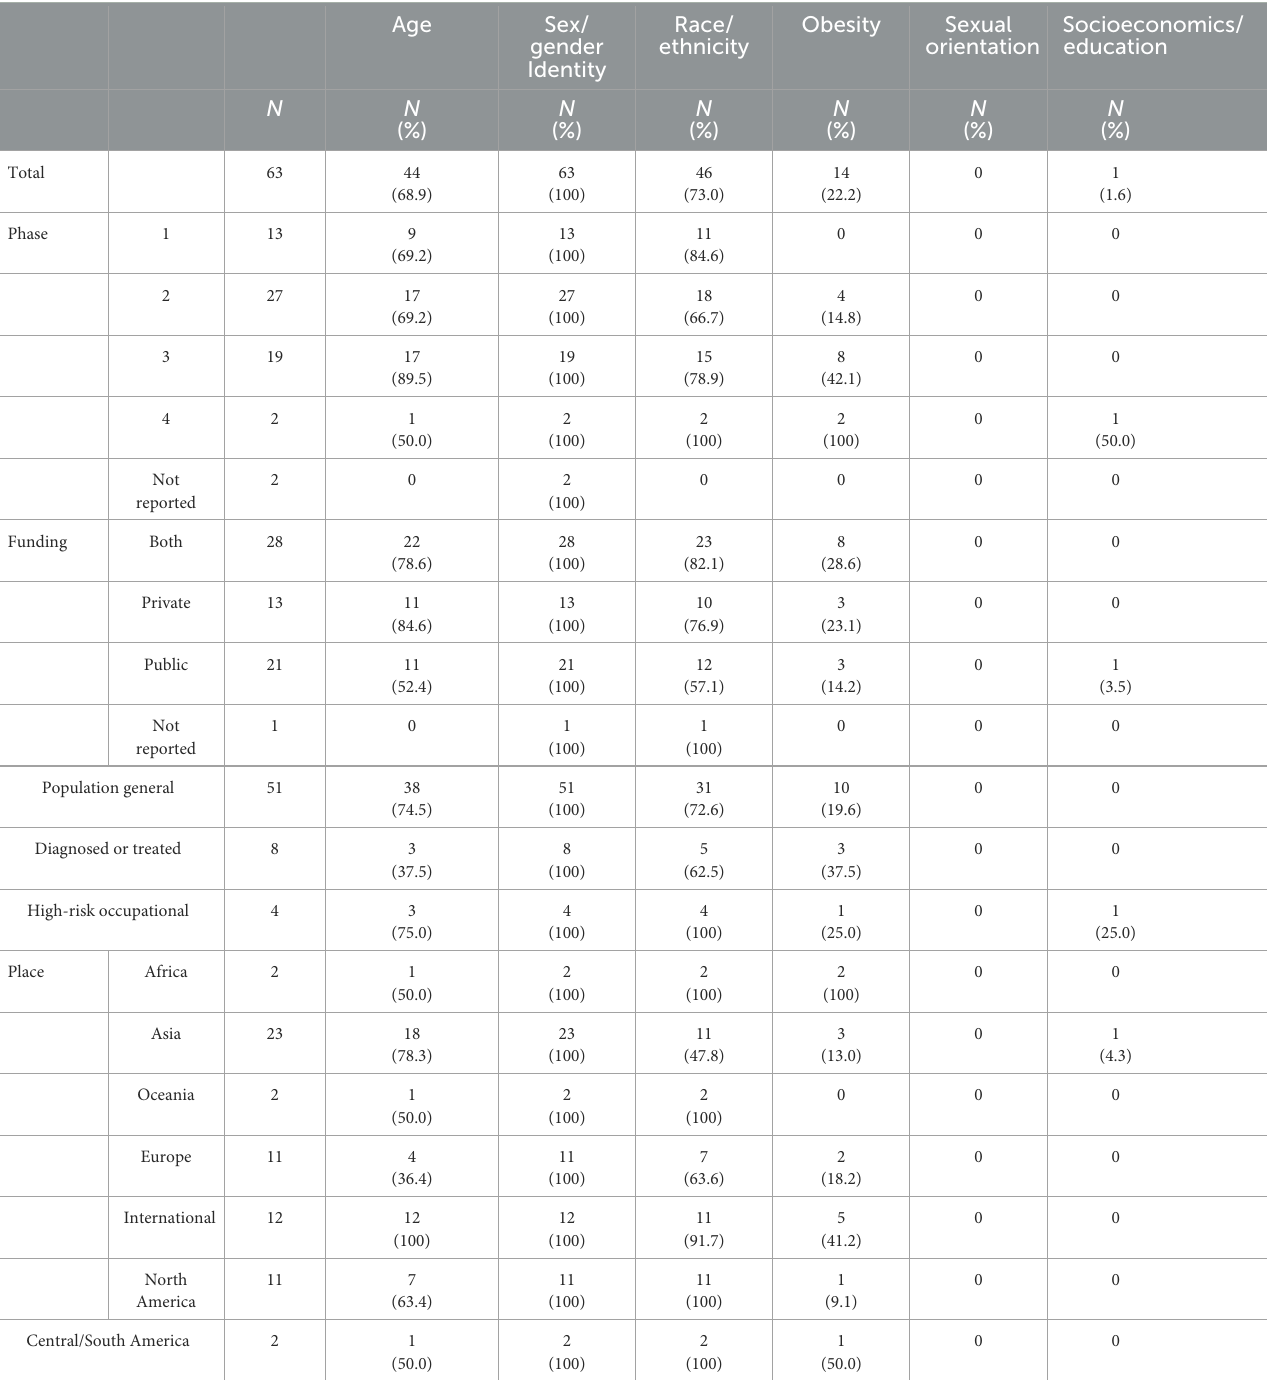
TABLE 2 Report of participants characteristics by axes of social inequity according to study characteristics.